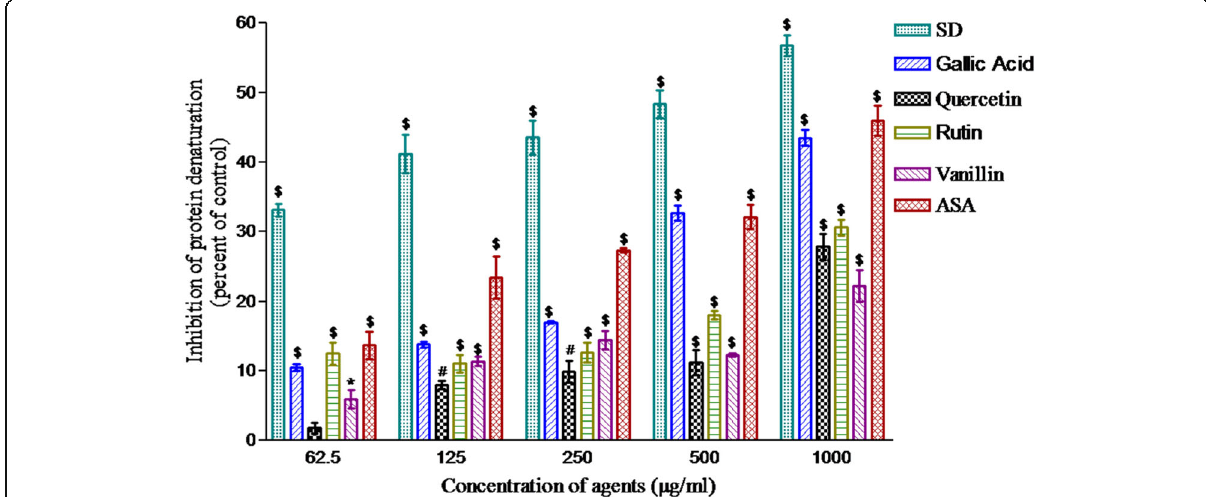
Fig. 2 Anti-inflammatory activity; inhibition in the heat induced denaturation of egg albumin protein. Sodium diclofenac, gallic acid, vanillin, acetylsalicylic acid, quercetin and rutin were added at 62.5 – 1000 μ g/ml. The tubes containing reaction mixture were incubated at 37 °C for 15 min and heated at 70 °C for 5 min. The tubes were allowed for cooling and absorbance was measured at 660 nm. Sodium diclofenac was used as a positive control. Values are represented as mean±SEM of three samples. * ( p <0.05), # ( p <0.01) and § ( p <0.001) represent significant changes relative to control